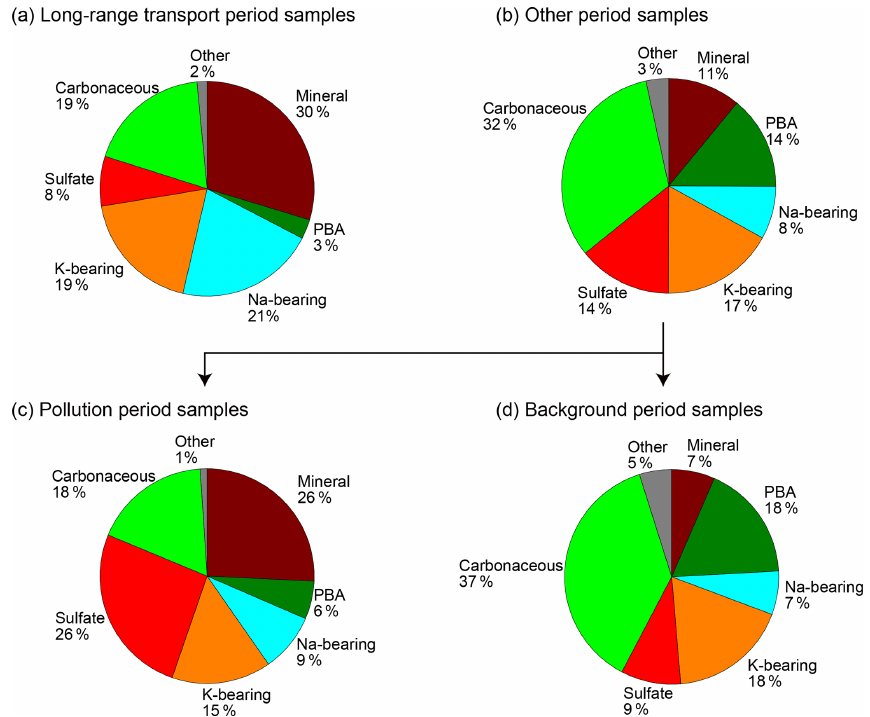
Figure 2. Number fractions of each aerosol particle type for average values during the (a) LRT period and (b) other period samples. Other periods were further divided into (c) pollution periods (14, 15, and 26 March 2014) and (d) background periods. See Fig. 1 for the sample classifications.